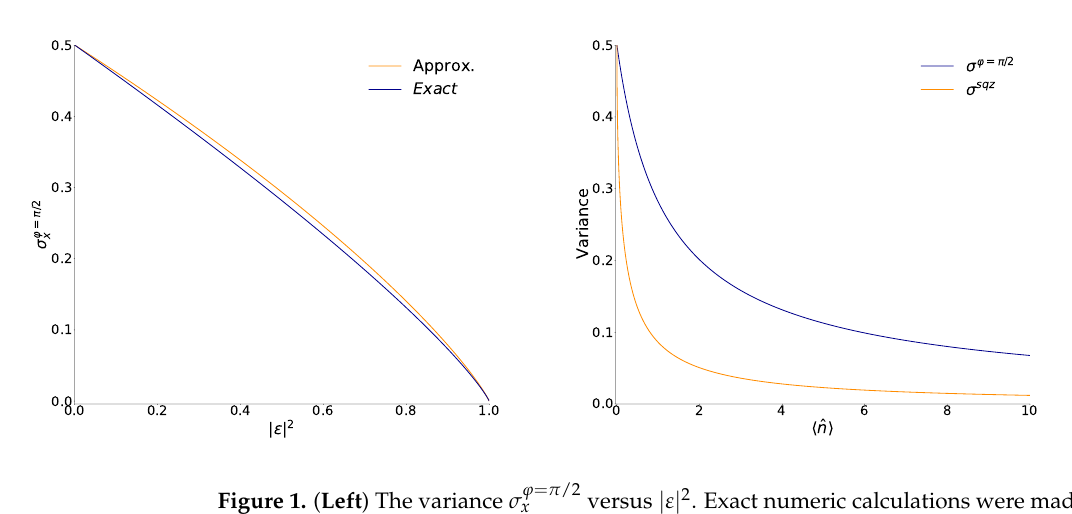
= π /2 | ε | 2 . Exact numeric calculations were made taking into Figure 1. ( Left ) The variance σ ϕ x versus = π /2 account 1000 terms in formula (12). ( Right ) The exact variance σ ϕ x versus the mean number of quanta (cid:104) ˆ n (cid:105) , compared with the variance (14) in the squeezed vacuum state. The mean values of the coordinate and momentum in the coherent state (5) satisfy the relation R ≡ (cid:104) ˆ x (cid:105) 2 + (cid:104) ˆ p (cid:105) 2 = 2 | α | 2 = 2 (cid:104) ˆ n (cid:105) . For the coherent phase state (2), we have R = 2 S 2 , 1 where S 1 is given by Equation (8). According to this equation, R ≈ 2 (cid:104) ˆ n (cid:105) for (cid:104) ˆ n (cid:105) (cid:28) 1. However, numeric calculations show that the plot of function R ( (cid:104) ˆ n (cid:105) ) for (cid:104) ˆ n (cid:105) (cid:29) 1 is very close to the straight line with a smaller inclination coefficient: R ≈ η (cid:104) ˆ n (cid:105) with η ≈ 1.59. A